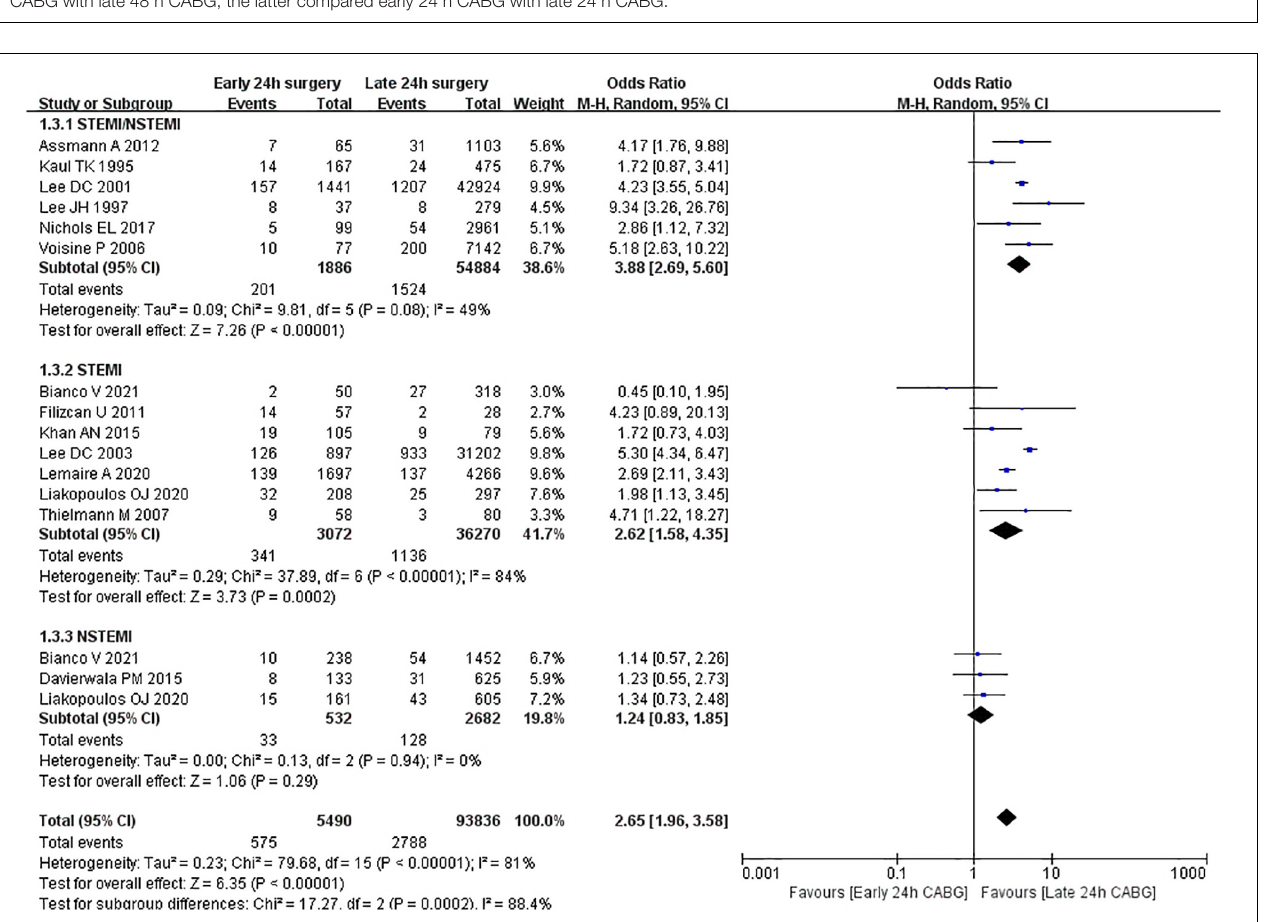
FIGURE 2 | The funnel plot for included studies. The funnel plot was symmetrical which meant no significant publication bias. The former compared early 48 h CABG with late 48 h CABG, the latter compared early 24 h CABG with late 24 h CABG.